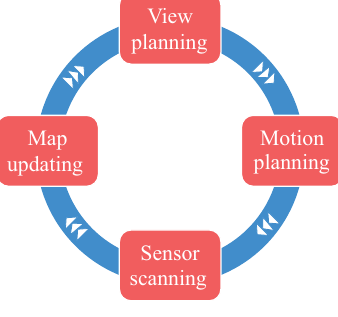
Fig. 5 Active vision